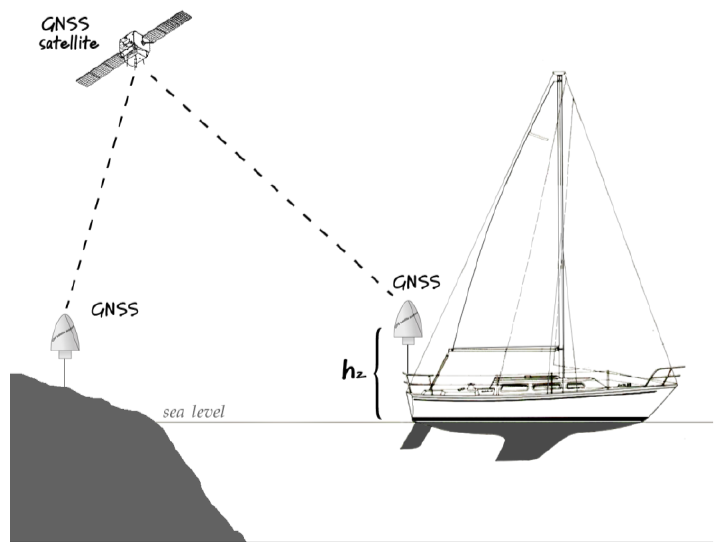
Figure 1. Schematic representation of the method “GNSS on boat” in its simplest form: The GNSS receiver on a ship, the fixed GNSS receiver on the land and the GNSS receiver on the satellite are illustrated.